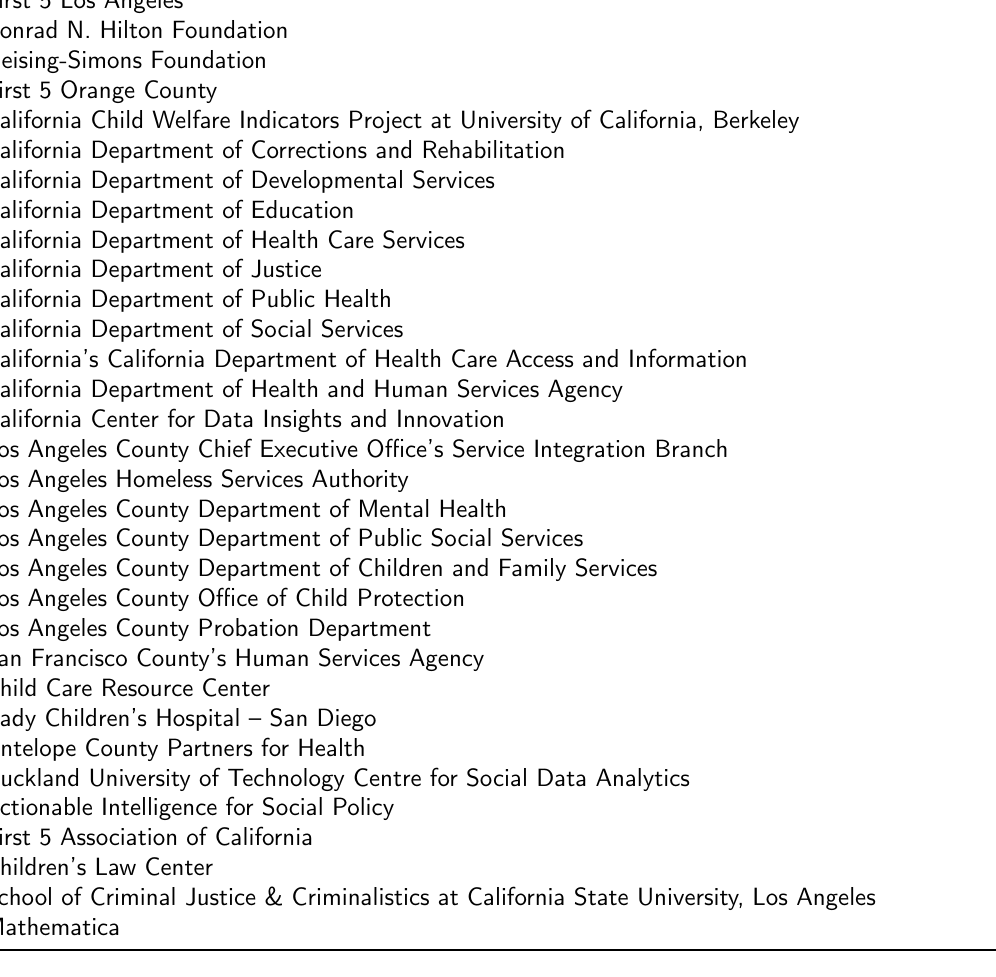
Table 2: Children’s Data Network data and research